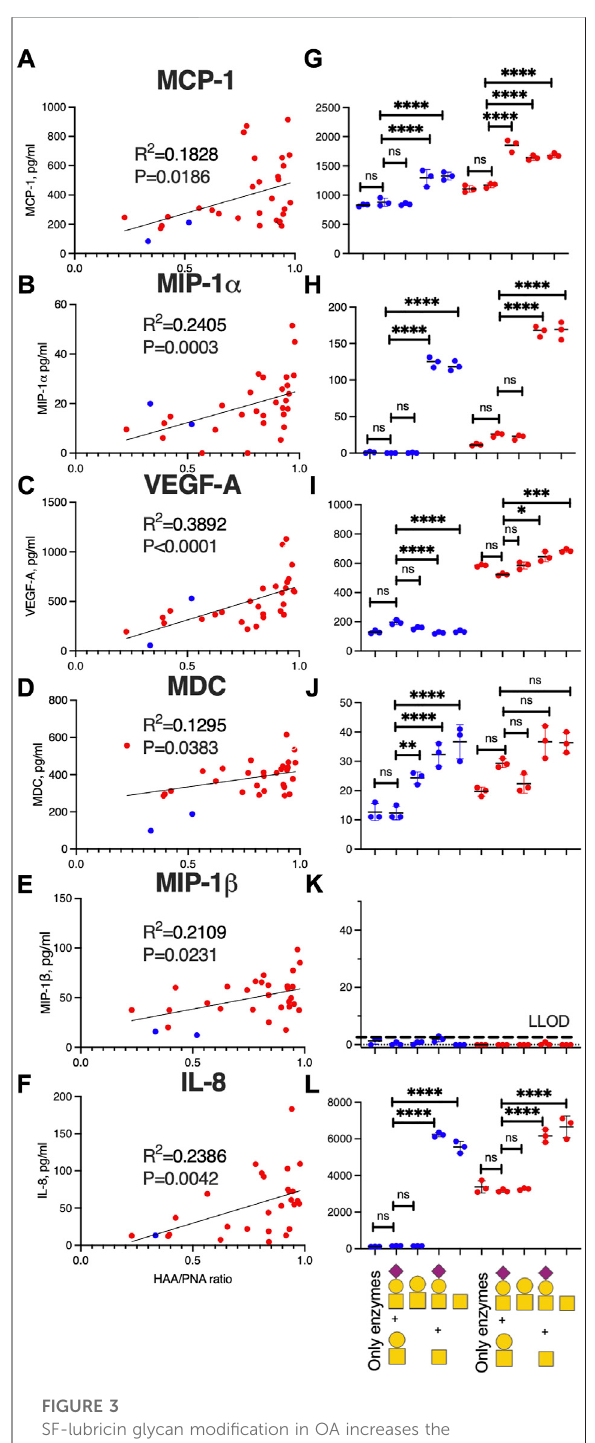
FIGURE 3 SF-lubricin glycan modi fi cation in OA increases the in fl ammatory biomarker expression. Left-hand panels (A – F) show correlations between HAA/PNA ratio and in fl ammatory cytokines in SF samples from OA patients (red dots, n = 29), also including non-OA SF-controls (blue dots, n = 2). Outliers were excluded from prior calculations according to the GOUT test with Q = 0.1. Spearman correlation (r S ) and p -values are displayed in each diagram. Right-hand panels (G – L) show cytokine concentrations in the medium (mean ± SD) secreted from